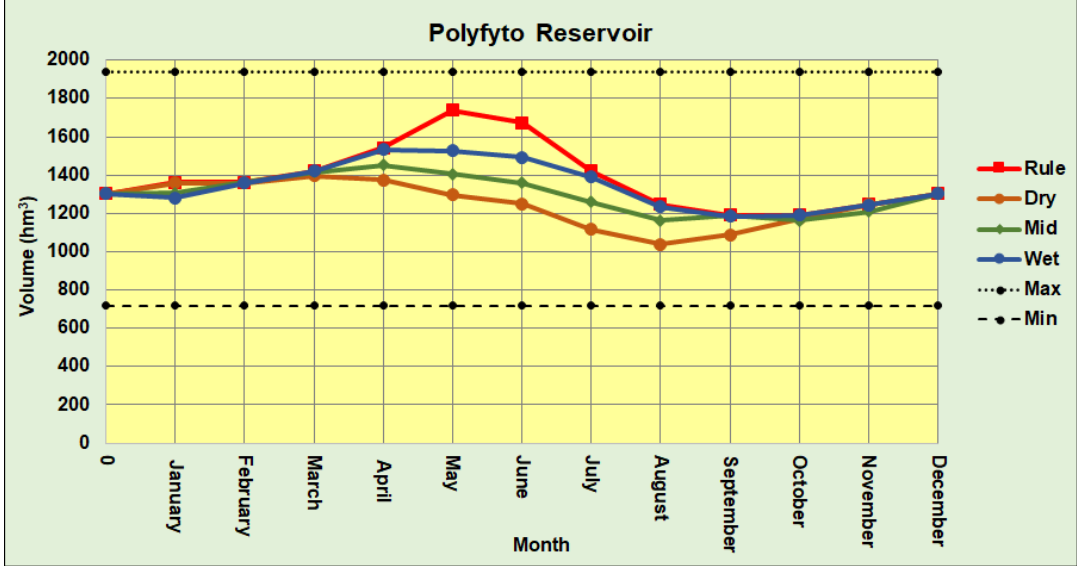
Figure 13. The optimal operation policies for the current state of water resources demand, applying the institutional operating rule curves for Polyfyto reservoir.